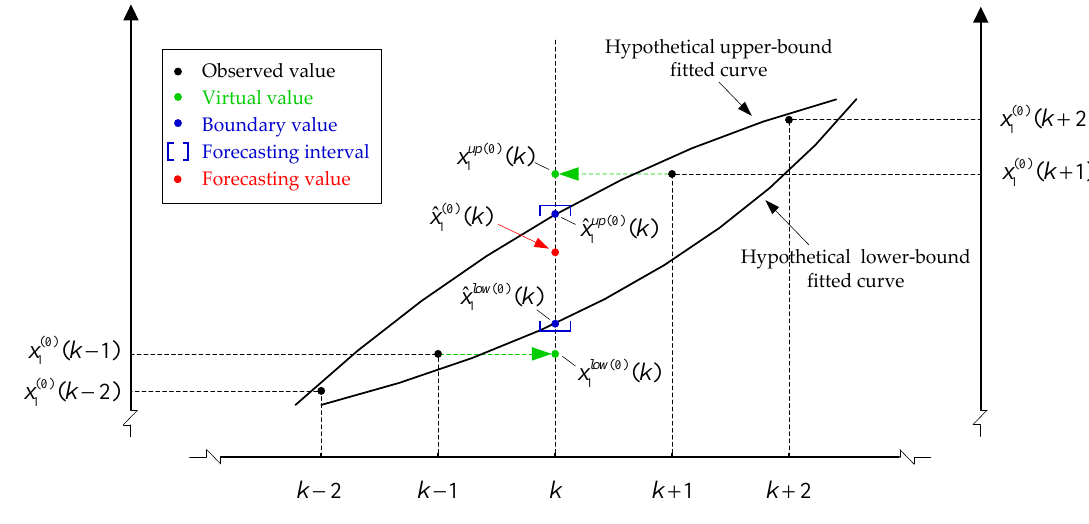
Figure 1. The schematic diagram of the whitenization method.